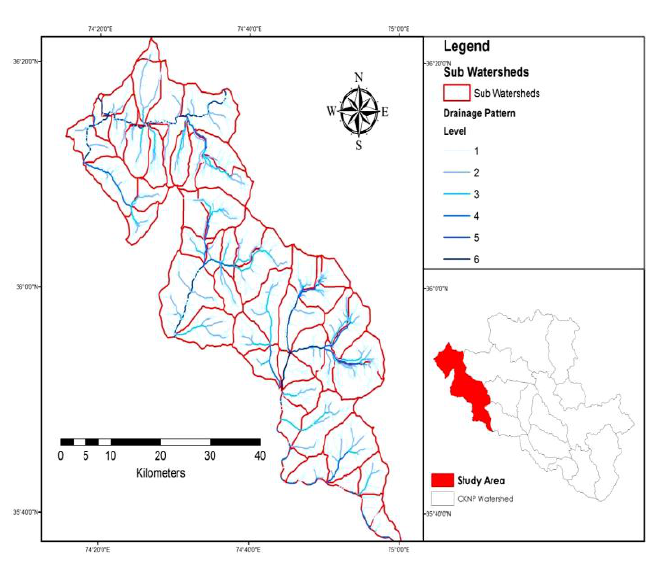
Figure 3: Drainage pattern of study area